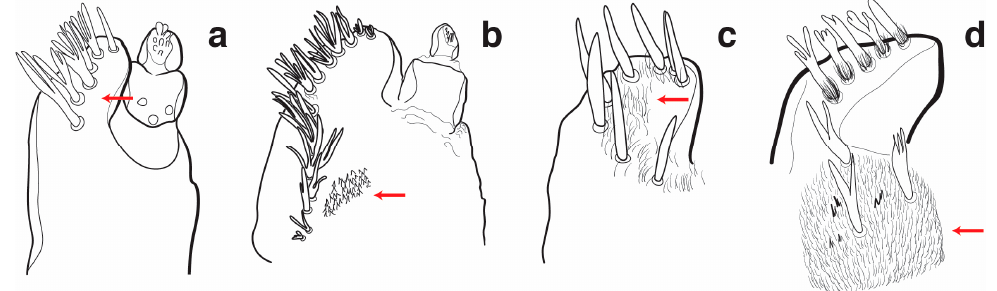
Figure 42. Mala and maxillary palp, larva, dorsal view: ( a ) Dryophthorus ; ( b ) Sipalinus ; ( c ) Rhodobaenus; and ( d ) Trigonotarsus .